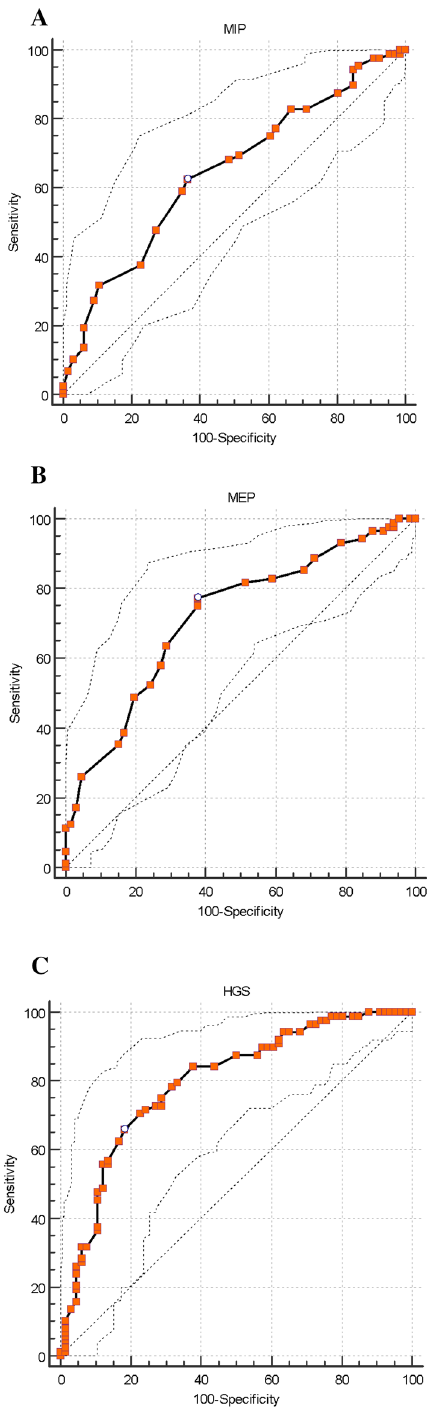
Figure 2. ROC curves for MIP, MEP and HGS. ROC curves for ( A ) MIP [AUC = 0.65 (0.56–0.73)], ( B ) MEP [AUC = 0.72 (0.64–0.80)], and ( C ) HGS [AUC = 0.80 (0.72–0.87)] in the screening of